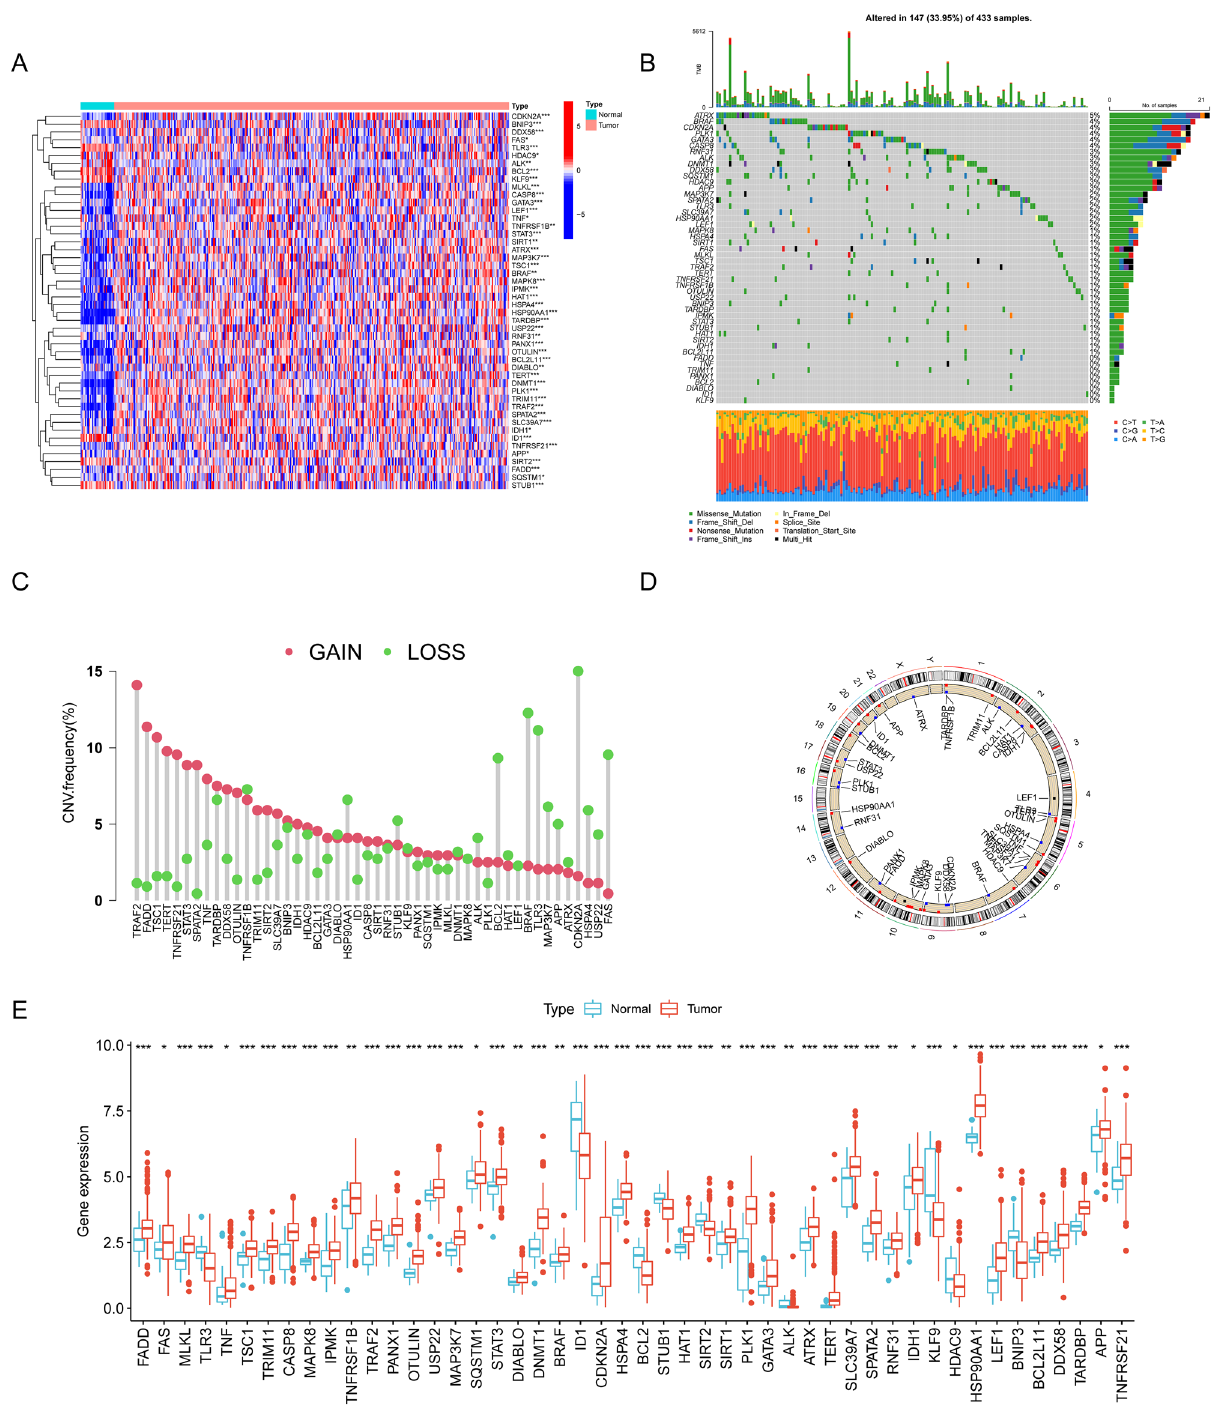
Figure 1. The landscape of genetic alterations of DENRGs in GC. ( A ) Heatmap of DENRGs expression between the normal and tumor samples. Blue represents normal gastric tissue, pink represents tumor tissue; upregulated genes were defined as red, and downregulated genes as blue. ( B ) Mutation characteristics of DENRGs in the TCGA-GC cohort. The TMB is presented in the barplot at the top of the image; the mutation frequency of each DENRGs is indicated on the barplot right. The barplot on the right represents different mutation types proportions. ( C ) CNV variants frequency of the DENRGs in the TCGA-GC cohort. Red: amplification frequency. Green: loss frequency. The column represented the alteration frequency. ( D ) The locations of CNV alteration of DENRGs on 23 chromosomes. ( E ) Expression of DENRGs between normal gastric tissue and tumor tissue. Blue: normal gastric tissue. Red: tumor tissue. DENRGs, differentially expressed necroptosis-related genes. (* p < 0.05; ** p < 0.01; *** p <